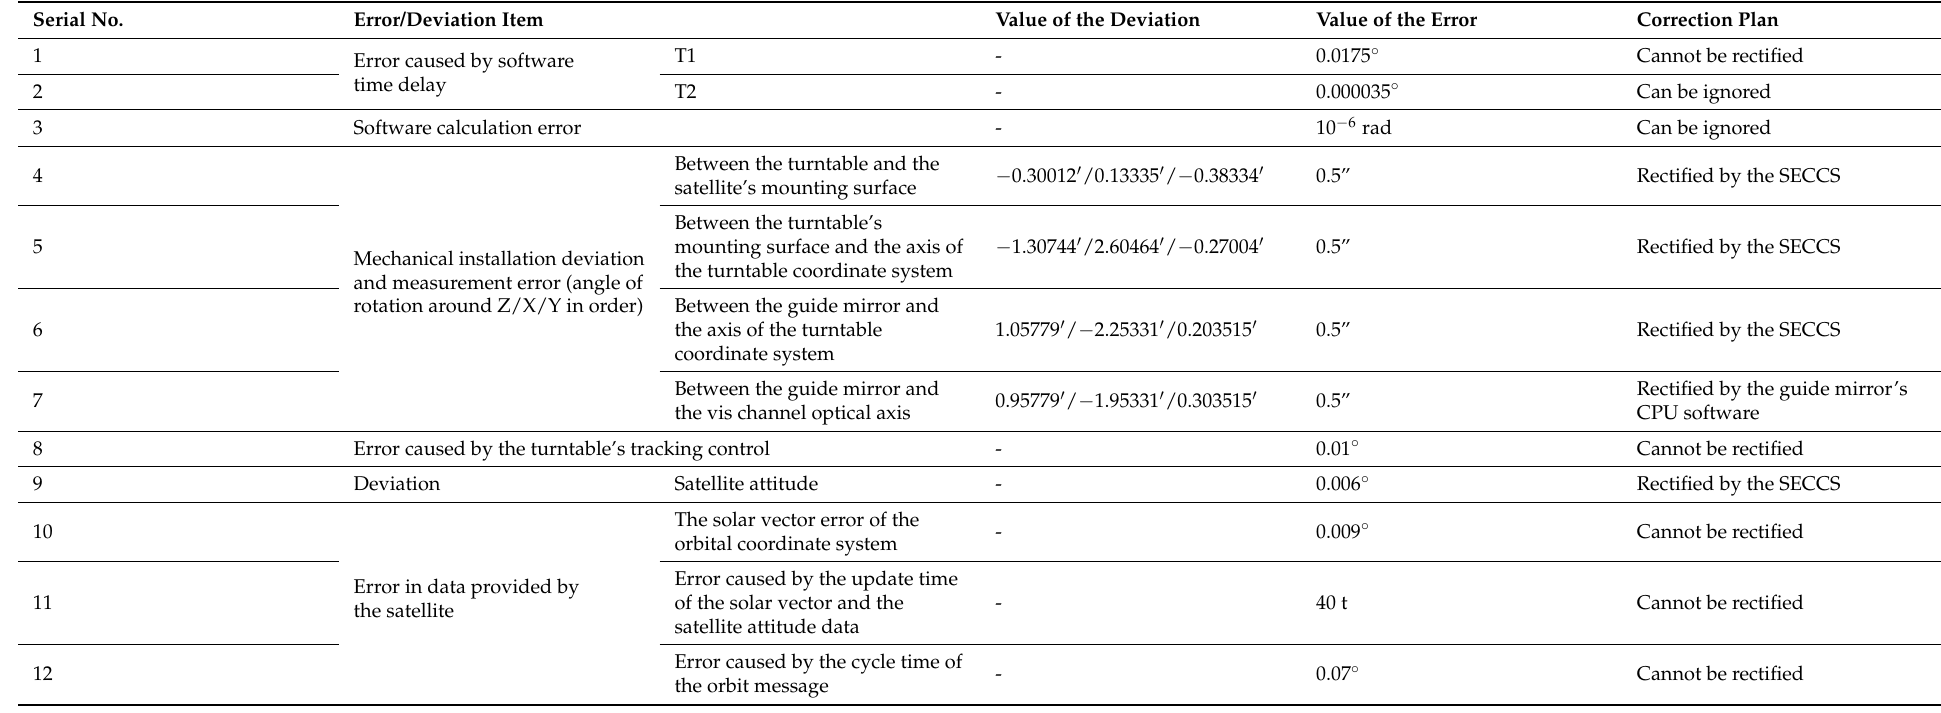
Table 1. The inherent errors and deviations of the solar tracking